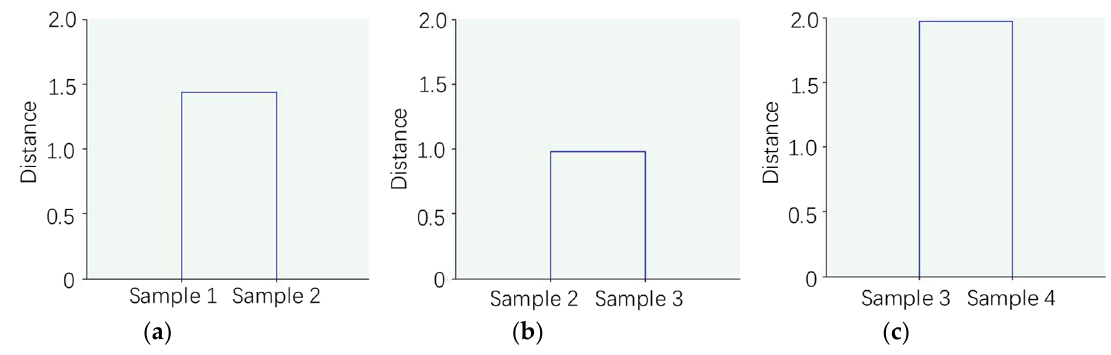
Figure 11. Distances among the four sample events after clustering analysis, showing: ( a ) Samples 1 and 2; ( b ) Samples 2 and 3; ( c ) Samples 3 and 4.